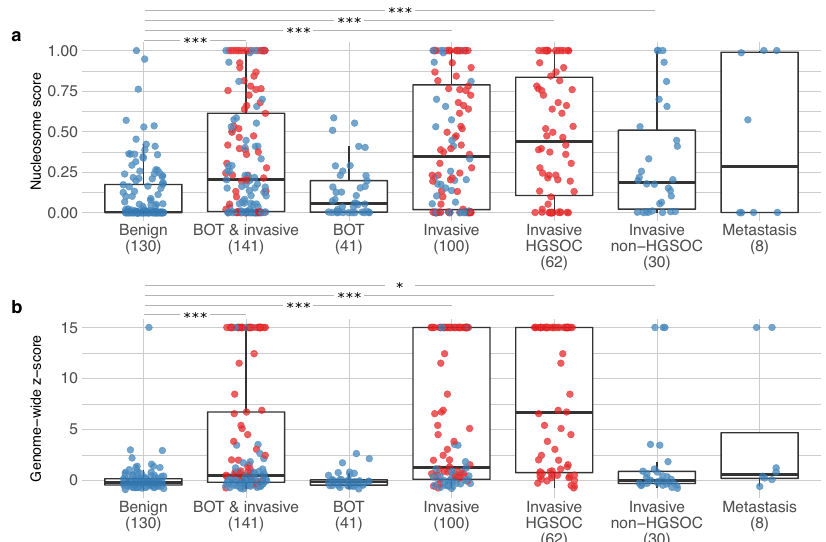
Fig. 2 Distribution of nucleosome scores and genome-wide z -scores, according to histology. Nucleosome scores ( a ) and genome-wide z - scores ( b ) are shown for 130 patients with benign ovarian disease, 141 patients with borderline and invasive carcinoma (including 8 patients with metastases) combined, 41 patients with borderline ovarian tumors (BOT), 100 patients with invasive ovarian carcinoma (including 8 patients with metastases), 62 patients with HGSOC, 30 patients with non-HGSOC, and 8 patients with adnexal metastases of other primary cancers. Every case is indicated by a blue dot and HGSOC cases are highlighted in red. The axis of the genome-wide z -scores was truncated for visualization purposes. *** p -value < 0.001; * p -value < 0.05 (Mann – Whitney). Further descriptive statistics are detailed in Supplementary Tables 2 and